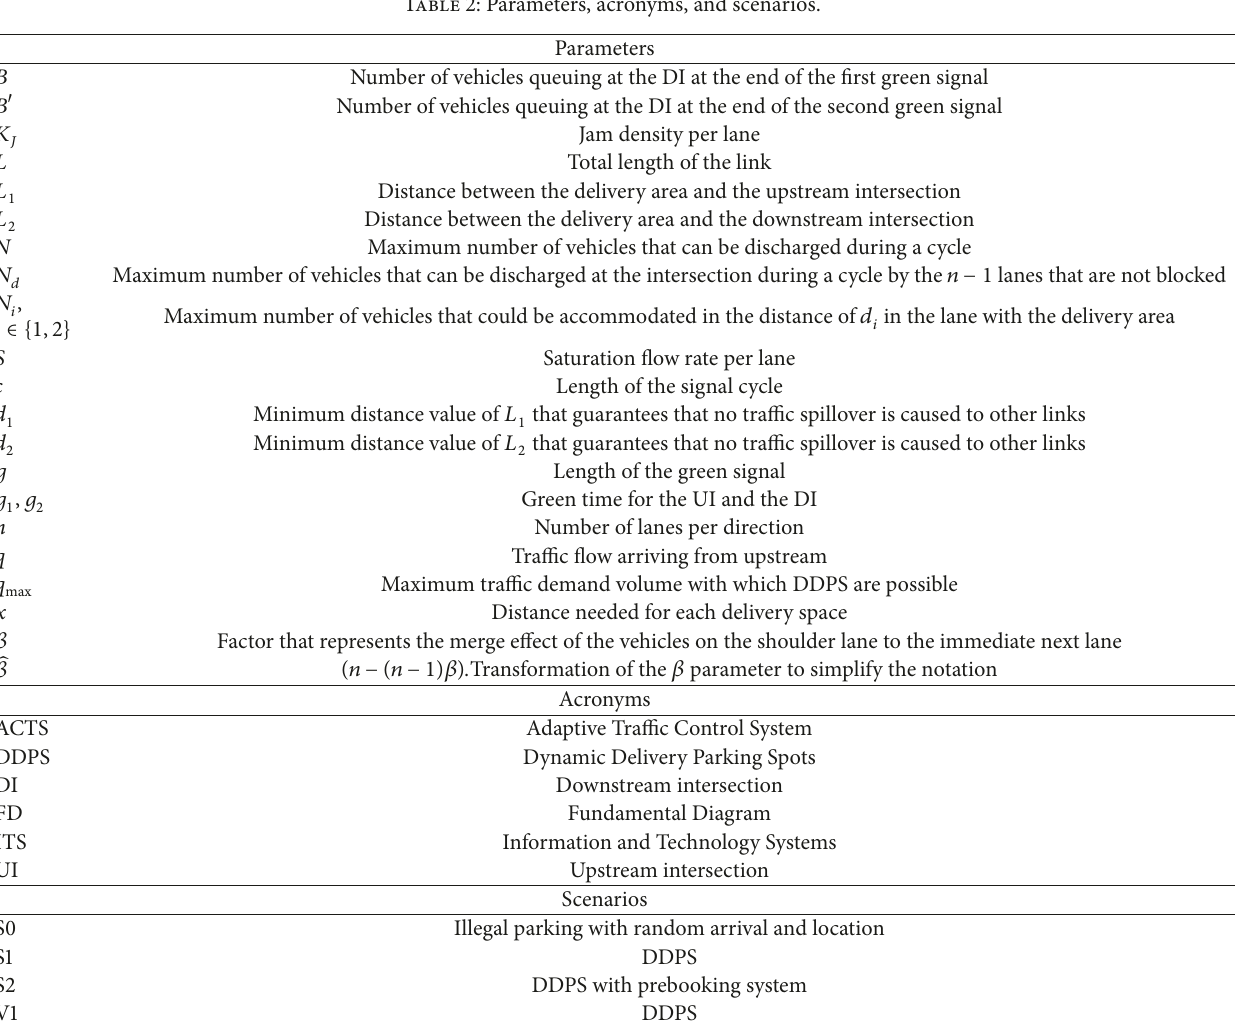
Table 2: Parameters, acronyms, and